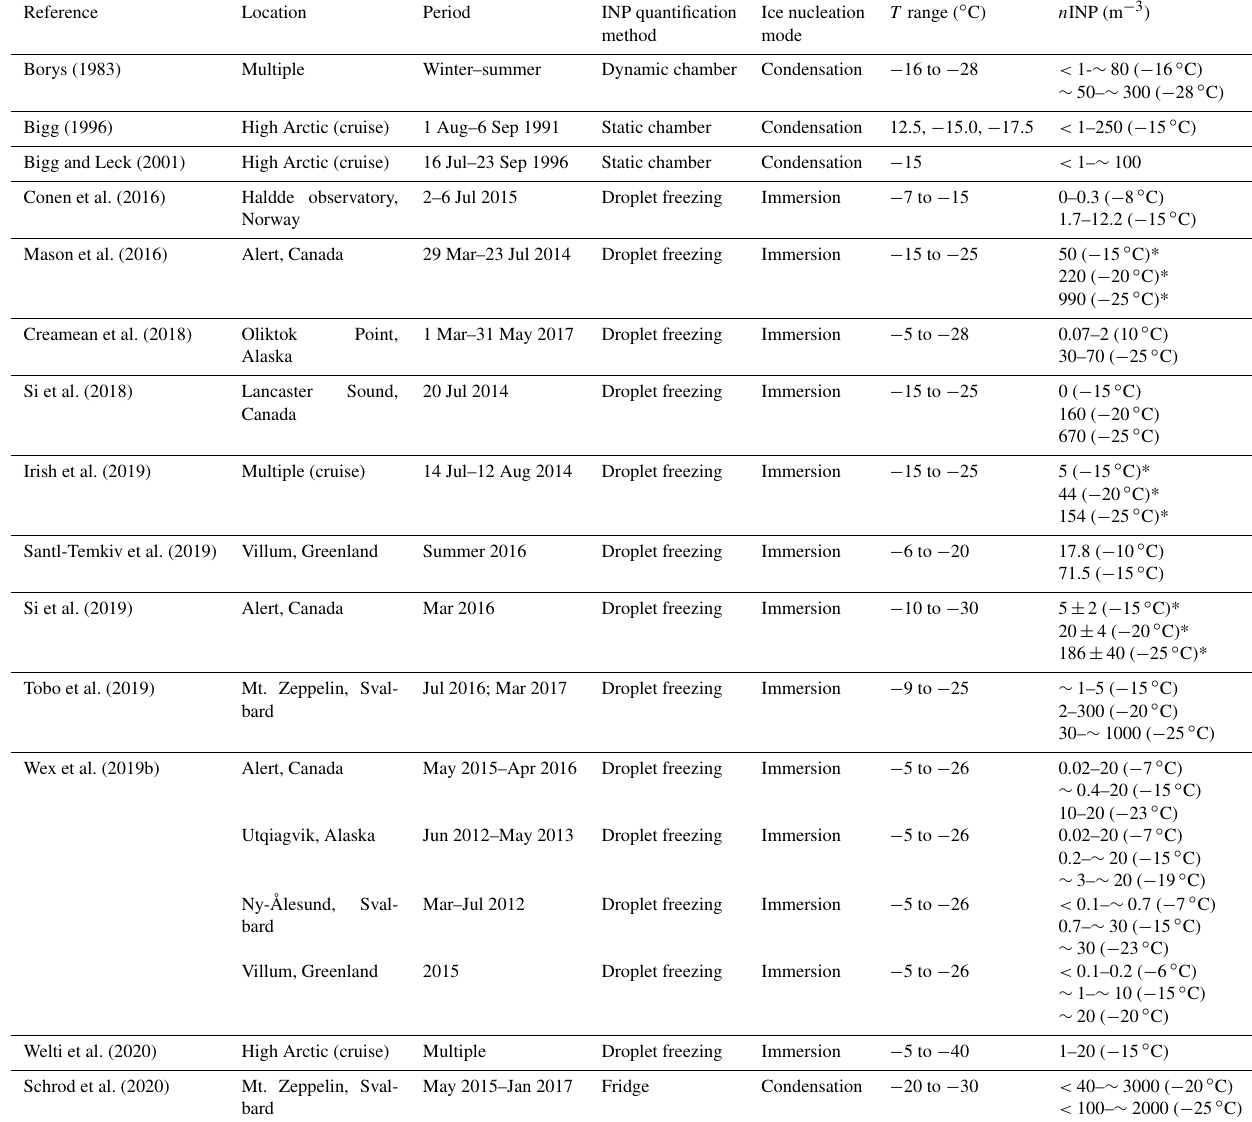
Table 1. Compilation of previous ground-level measurements of n INP in the